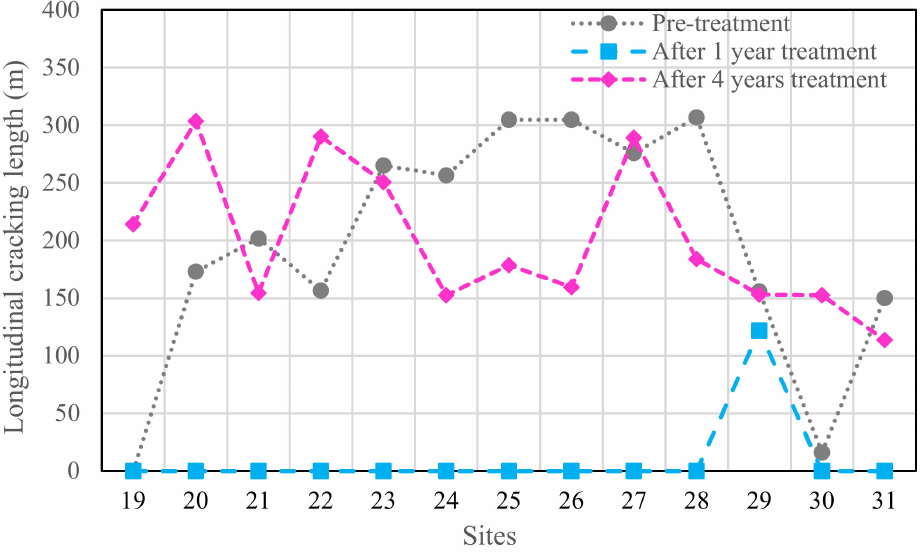
Figure 9. EffectivenessofWMAoverlaycontainingRAPonlongitudinalcrackingunderwetclimatic